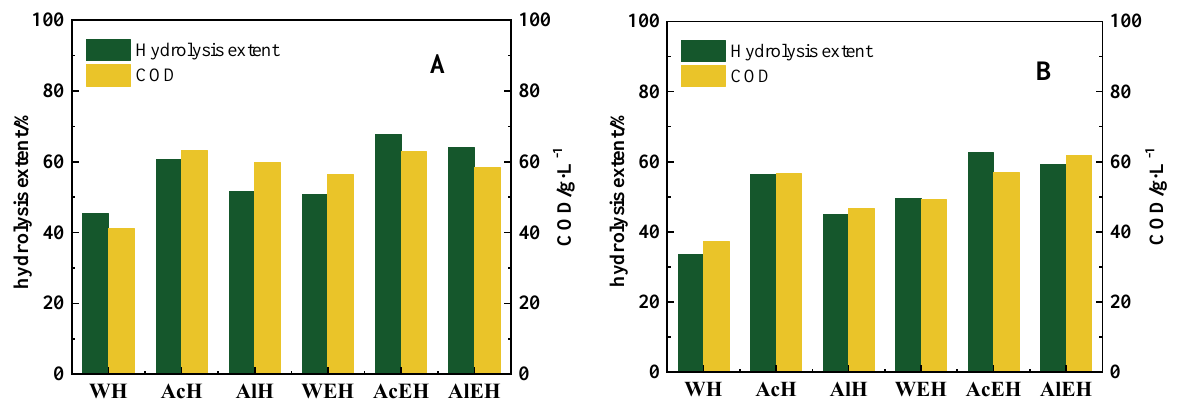
Figure 2. Hydrolysis extent and COD of different straw hydrolysates. ( A ) CS hydrolysates; ( B ) SS hydrolysates.